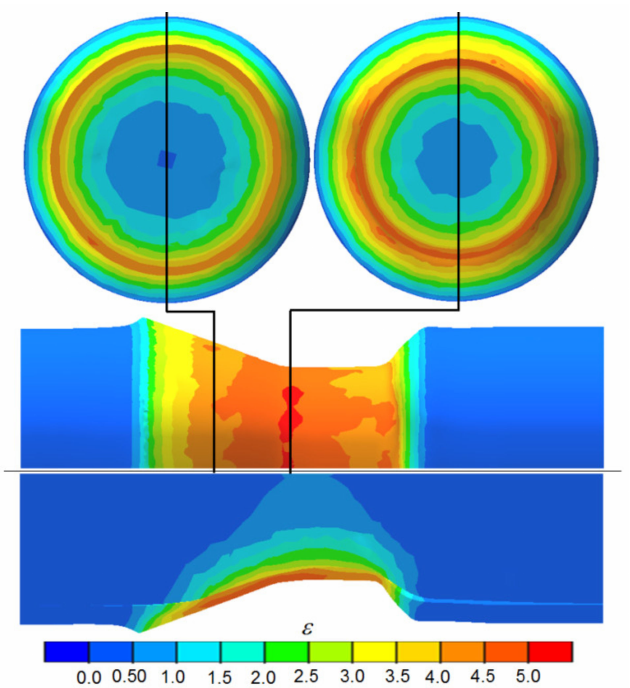
Figure 12. Distribution of effective plastic strain during the rolling of bimetallic rods modeled by